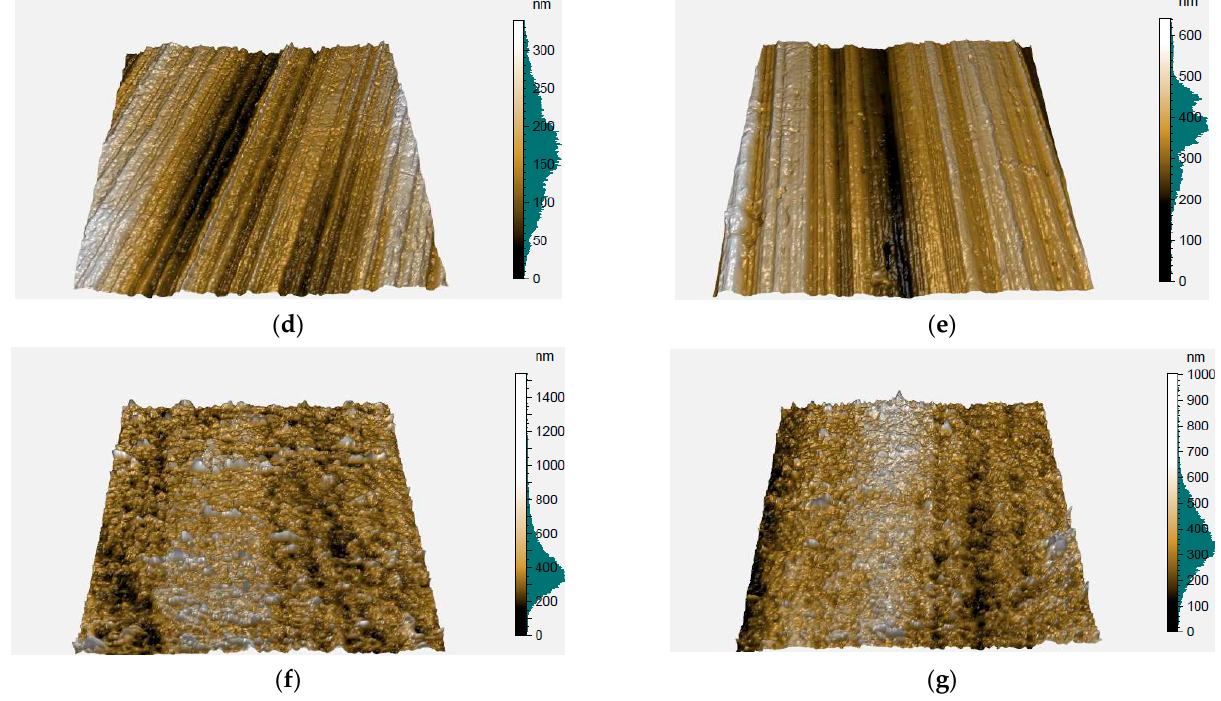
Figure 1. AFM images of the Cu surface ( a ) before tests and after 3 weeks of immersion test in ( b ) solution no1, ( c ) solution no2, ( d ) solution no3, ( e ) solution no4, ( f ) solution no5, and ( g ) solution no6. (Measurement area was 50 μ m × 50 μ m).